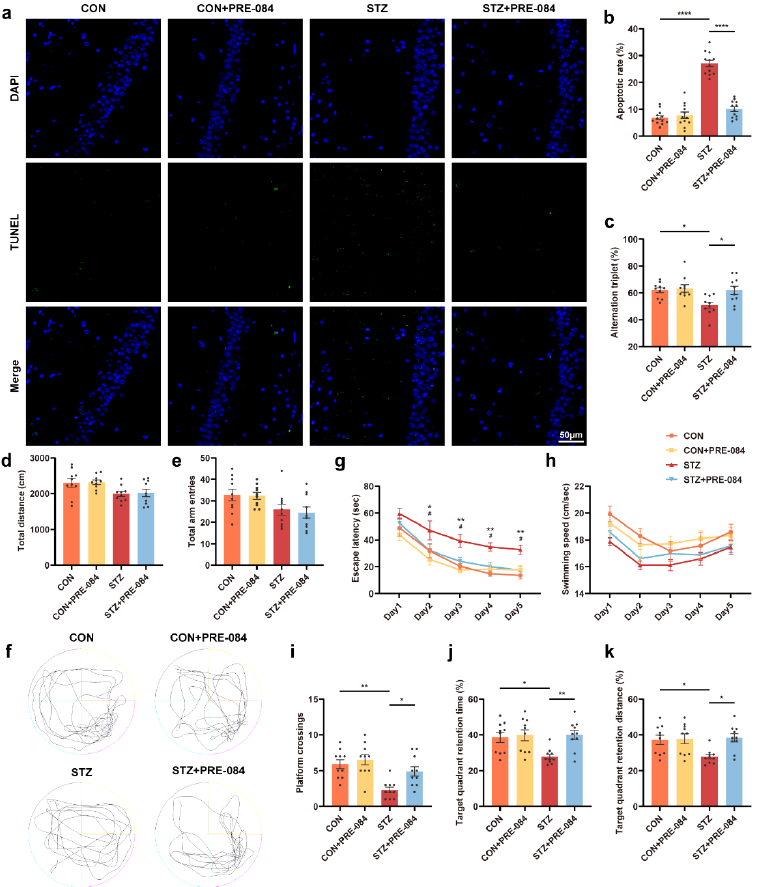
Figure 4. The effect of Sig-1R agonist on cognitive function in mice with T1DM. ( a ) Representative images of TUNEL labeling in the hippocampal CA1 region in the CON, CON + PRE-084, STZ, and STZ + PRE-084 groups. Green staining indicated TUNEL-positive cells, and blue staining indicated DAPI. The scale bar is 50 μ m. ( b ) Quantitation of TUNEL-positive cells in the hippocampal areas ( n = 12; 3 mice per group). ( c – e ) Y-maze alternation triplet (%) ( c ), total distance ( d ), and total arm entries ( e ) ( n =10 mice for all groups). ( f – k ) Representative traces for MWM test ( f ) and the quantitation of escape latency ( g ), swimming speed ( h ), platform crossings ( i ), target quadrant retention time ( j ), and target quadrant retention distance ( k ) ( n = 10) (* CON vs. STZ, # STZ vs. STZ + PRE-084). The data were presented as mean ± SEM and analyzed via one-way or two-way ANOVA with Tukey’s multiple comparison tests. * p < 0.05; # p < 0.05; ** p < 0.01; **** p < 0.0001. Sig-1R, sigma-1 receptor; T1DM, type 1 diabetes mellitus; TUNEL, terminal deoxynucleotidyl transferase-mediated dUTP nick-end labeling; CON, control mice; STZ, mice with T1DM; MWM, Morris water maze.